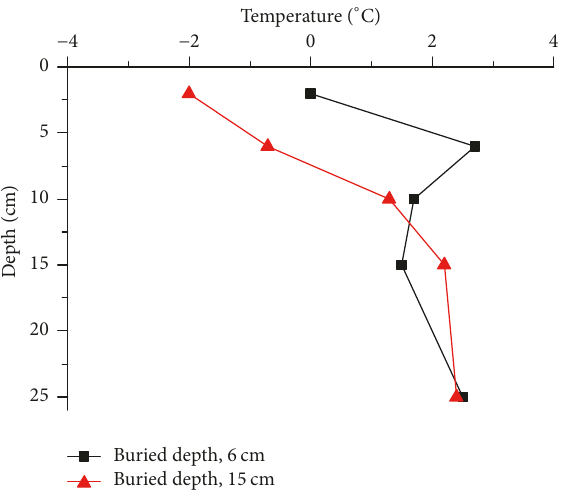
Figure 8: Impact of heat pipe embedded depth on pavement temperature field.